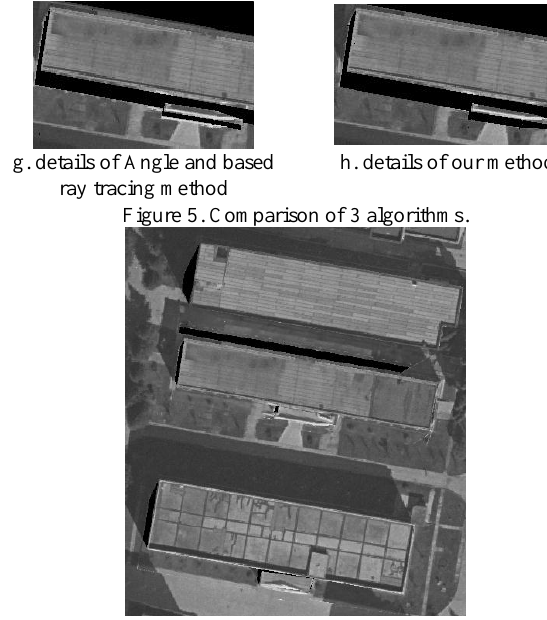
Figure 5. Comparison of 3